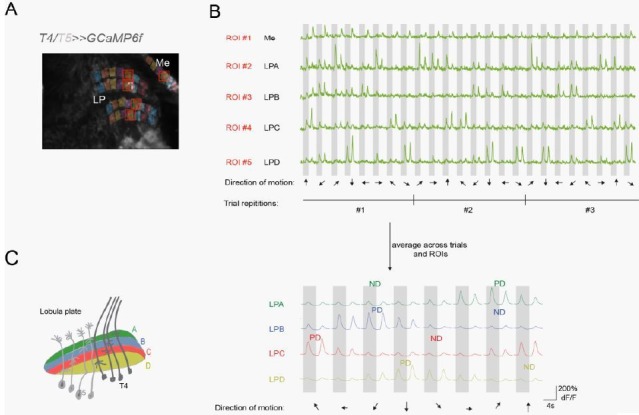
Extraction of PD and ND responses from T4/T5 calcium imaging data.(A) Expression of GCaMP6f in T4/T5 neurons. ROIs are manually drawn and assigned to different lobula plate (LP) or medulla (Me) layers. (B) Single ROI responses to ON (bright background) and OFF (grey background) moving into different directions of motion. (C) Upon averaging across trials and ROIs, the preferred direction (PD) is determined as the direction of motion that was eliciting the strongest response. The null direction (ND) is set as the direction of motion that is 180° relative to the PD.